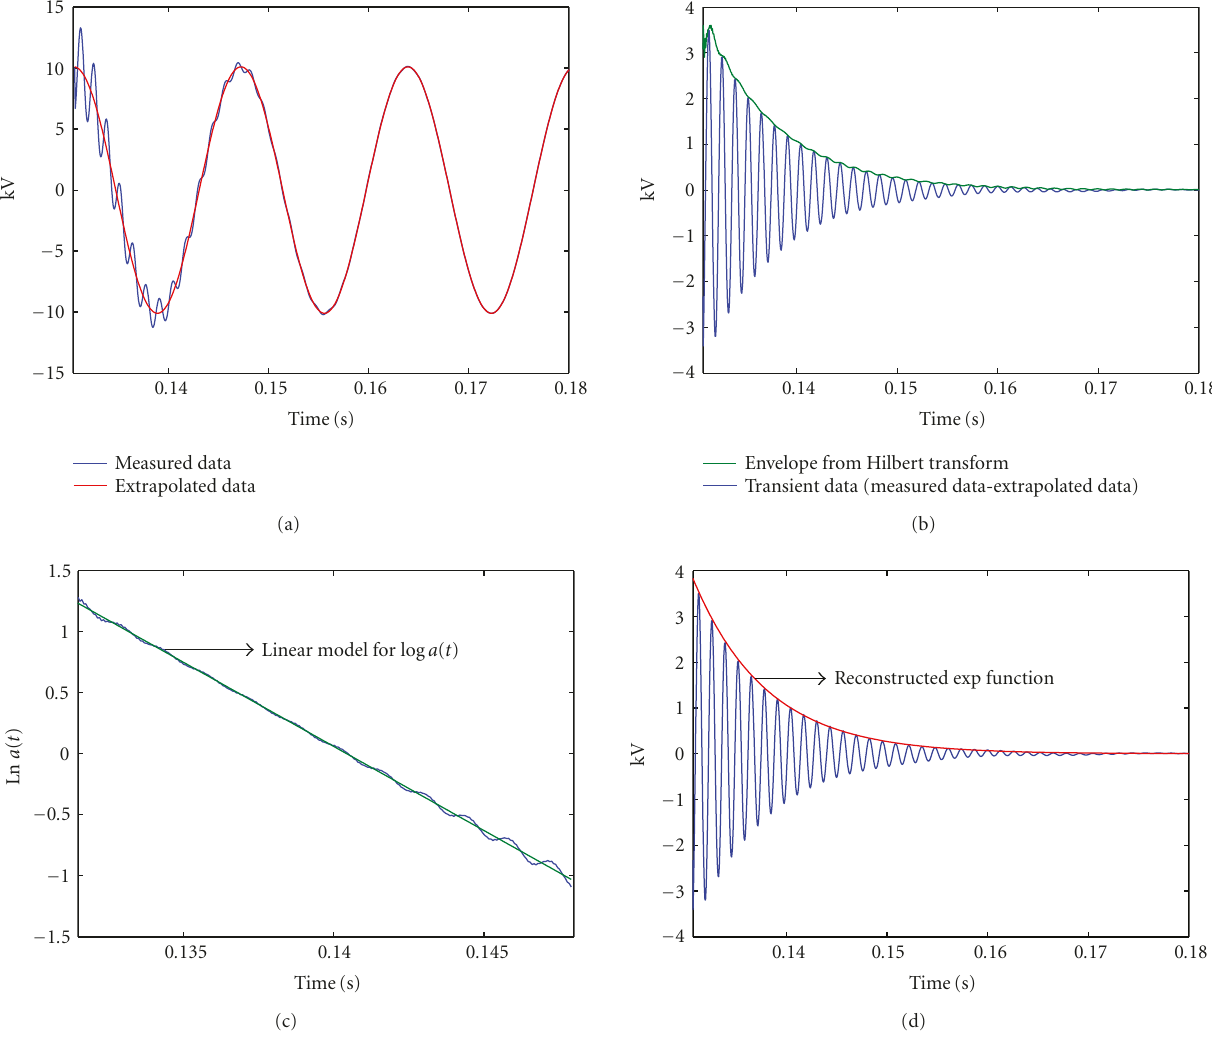
Figure 4: Step-by-step procedures of the proposed damping estimation method. (a) Extracting the transient voltage di ff erential between the measured data (bold) and the extrapolated data (solid), (b) detecting envelope by way of Hilbert transform, (c) performing linear regression for the natural logarithms of the envelope, which results in the e ff ective X/R ratio, and (d) reconstructing exponential function that perfectly fits in the voltage transient response.